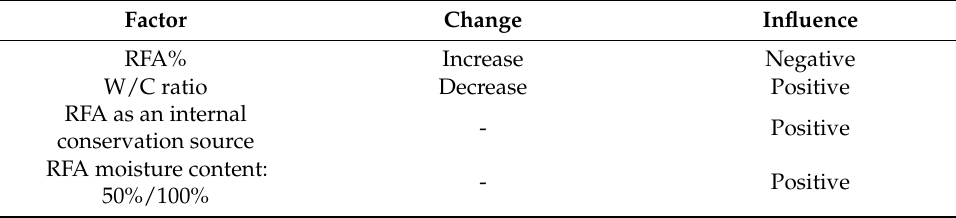
Table 4. The influence of different factors on the freeze–thaw resistance of RFAc. Factor Change Influence RFA% Increase